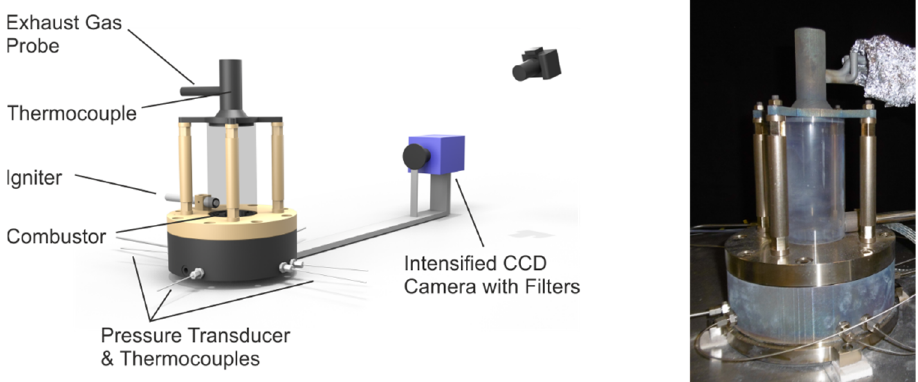
Figure 4. Setup of the atmospheric test rig [55] and combustor with the used optical combustion chamber.